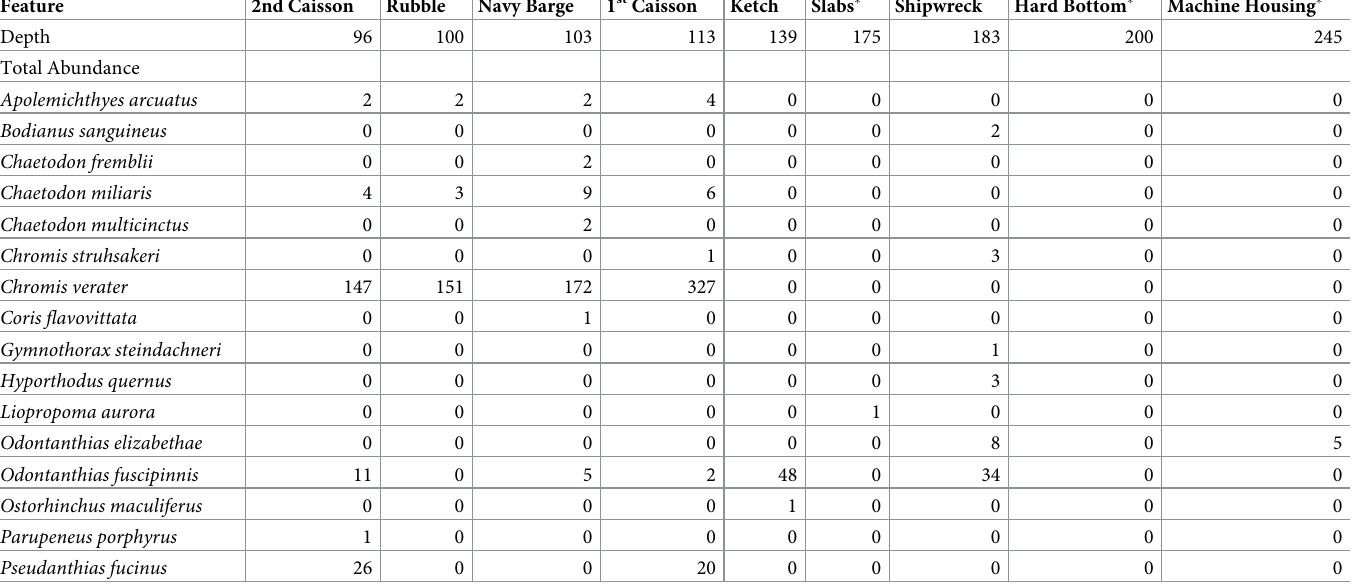
Table 4. Endemic species. Features marked with an asterisk were only surveyed